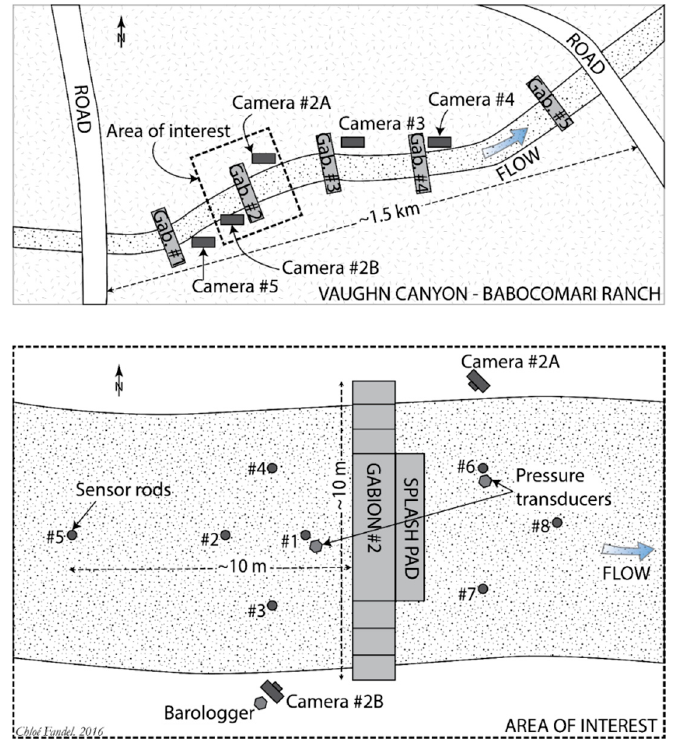
Figure 5. Diagram portraying location of instruments around Gabion #2 (drawing by C. Fandel).